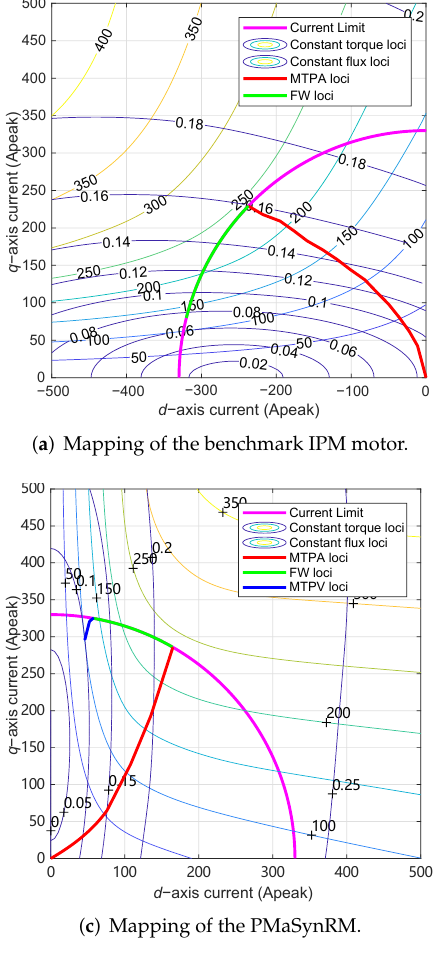
Figure 13. Comparison of the current vector trajectory of the three motors.